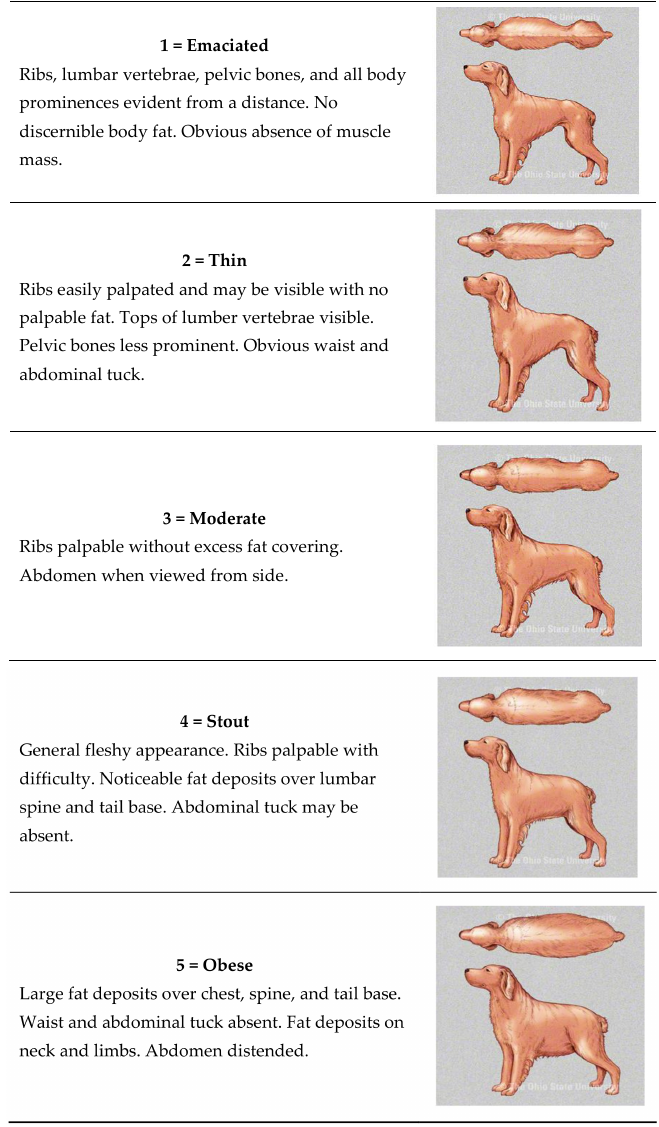
Figure A1. Body condition scoring. The tool used to assess BCS